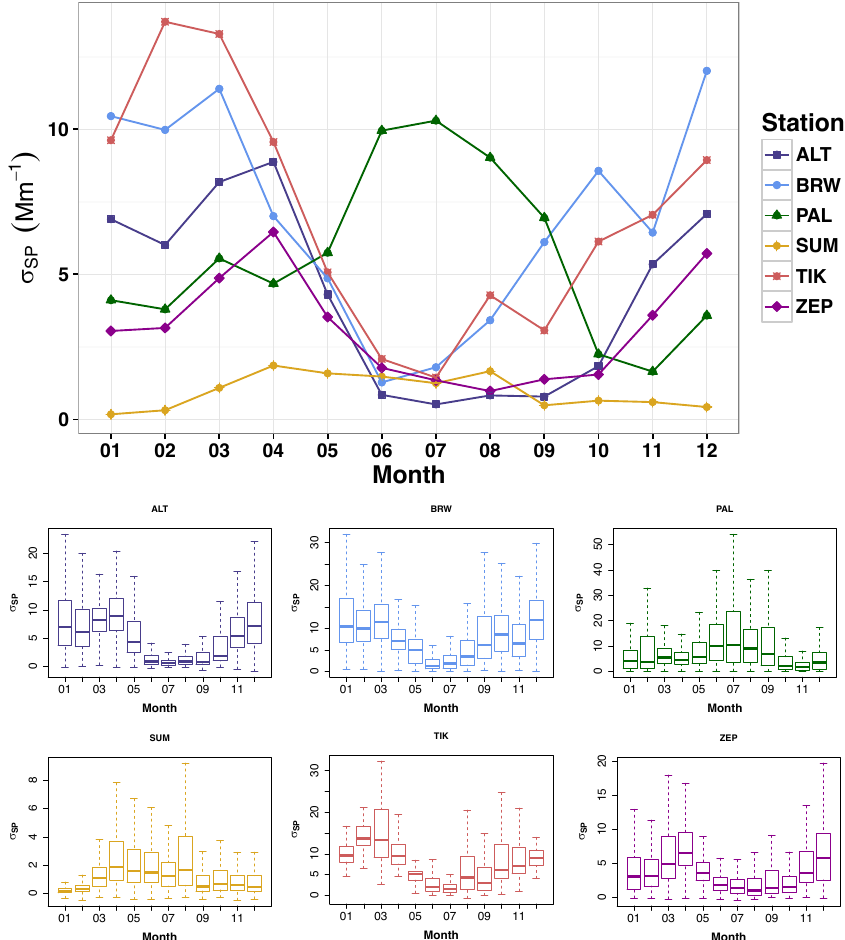
Figure 3. Seasonality of the aerosol light-scattering coefficient ( σ sp ) at 550nm at all sites. Large plot shows monthly medians of scattering per megameter (Mm − 1 ) at each station; subplots below show boxplots of hourly average scattering at individual sites, with horizontal line at the median, edges of the box at 25th and 75th percentiles, and whiskers at 5th and 95th percentiles. Note that y axes are different on each plot. Size cuts for the scattering measurements are as follows: 10µm (ALT), 10µm (BRW), 10µm (PAL), 2.5µm (SUM), 10µm (TIK), and no size cut at